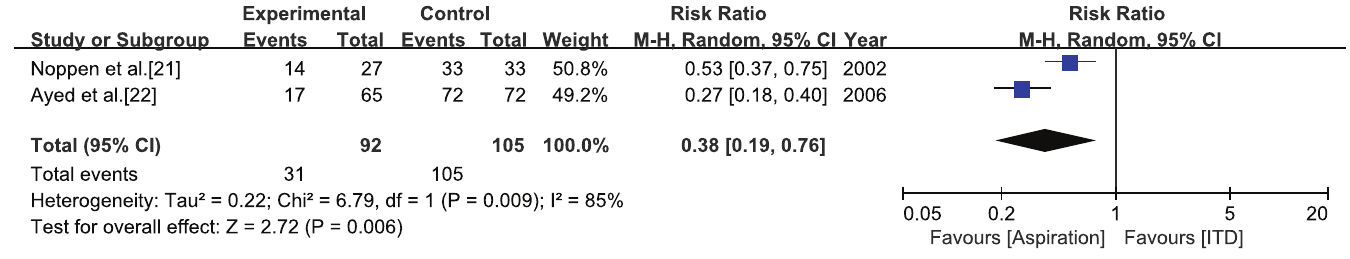
Fig 5. Meta-analysis of the hospitalization rate associated with aspiration versus intercostal tube drainage.